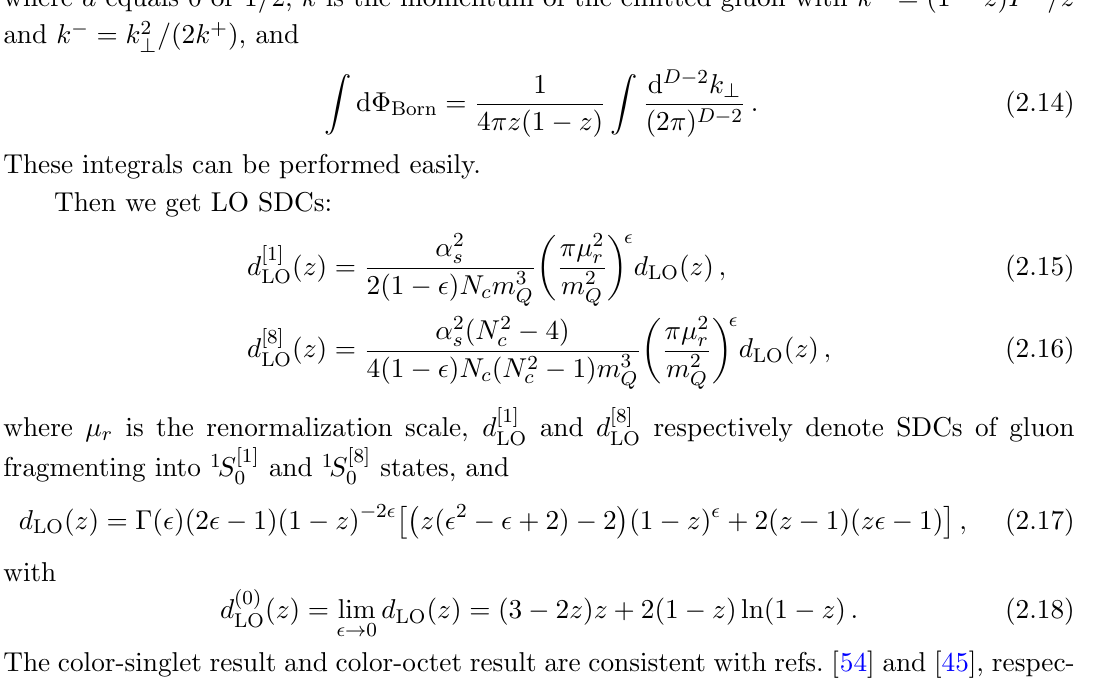
Figure 2 . One of the two Feynman diagrams of gluon fragmenting into 1 S [1] (cid:11) s . Another diagram can be obtained by permuting the heavy quark and anti-quark.